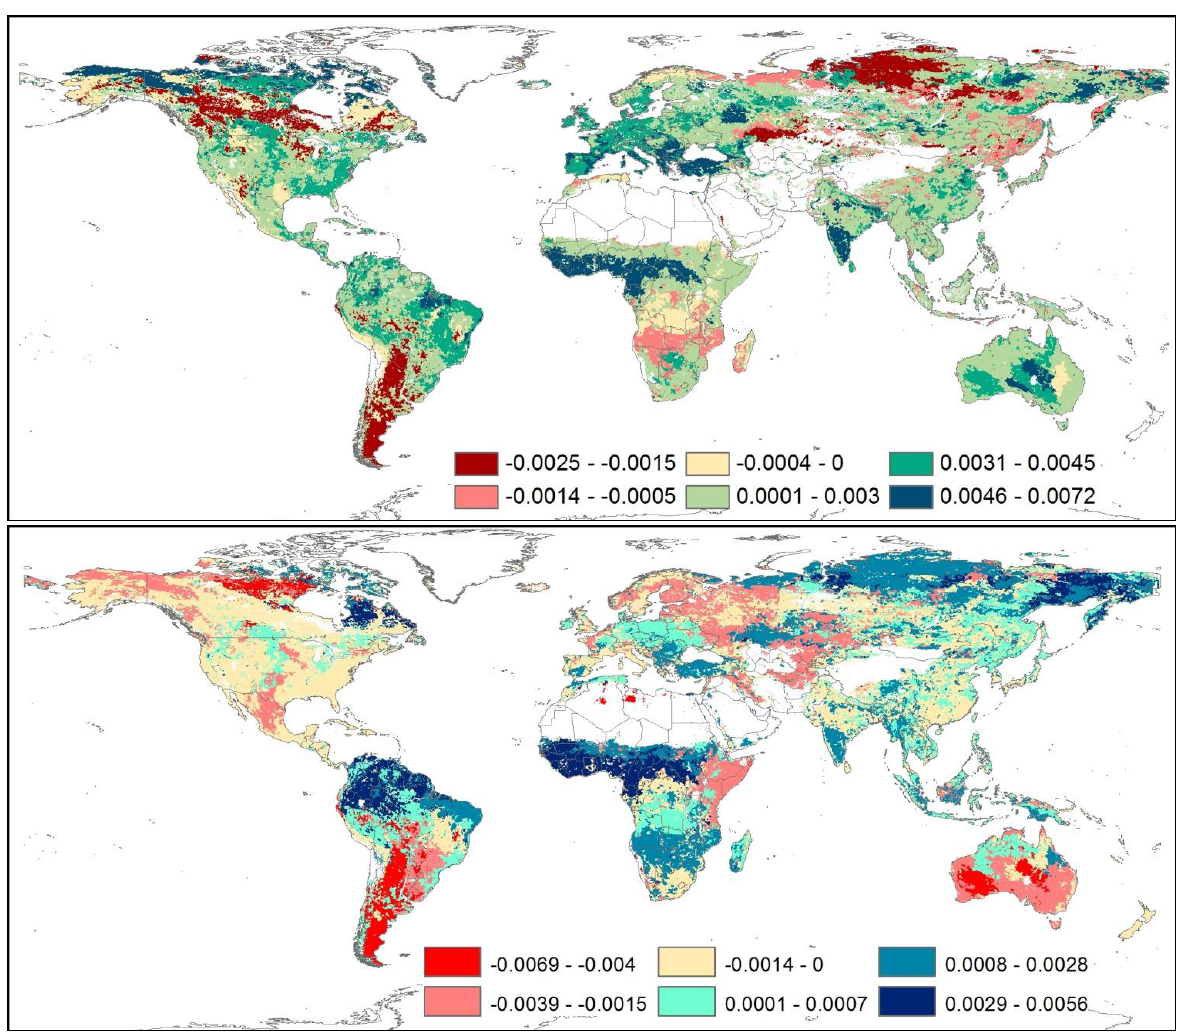
Figure 7. Non-parametric (Theil-Sen) slopes for the FPAR3g ( top ) and SPEI12 ( bottom ) anomalies for the ERTs for the years